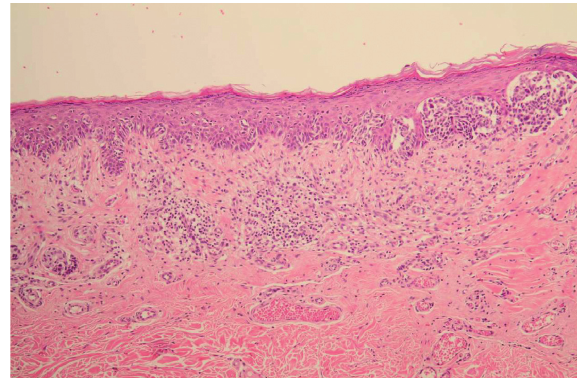
Figure 5: The lesion is characterized by atypical junctional activity and signs of extensive regression in the superficial dermis (HE × 10).